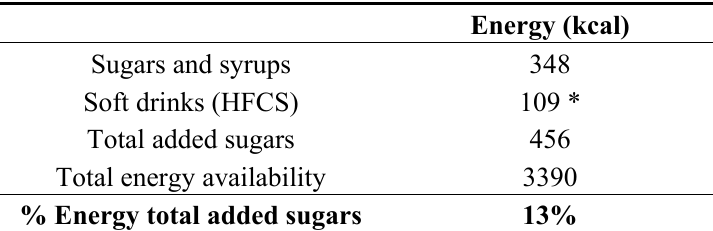
Table 3. Estimated average energy available from total added sugars in Canada for the last available five years